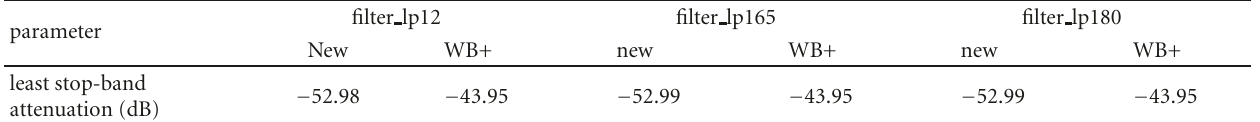
Table 3: New filter parameter